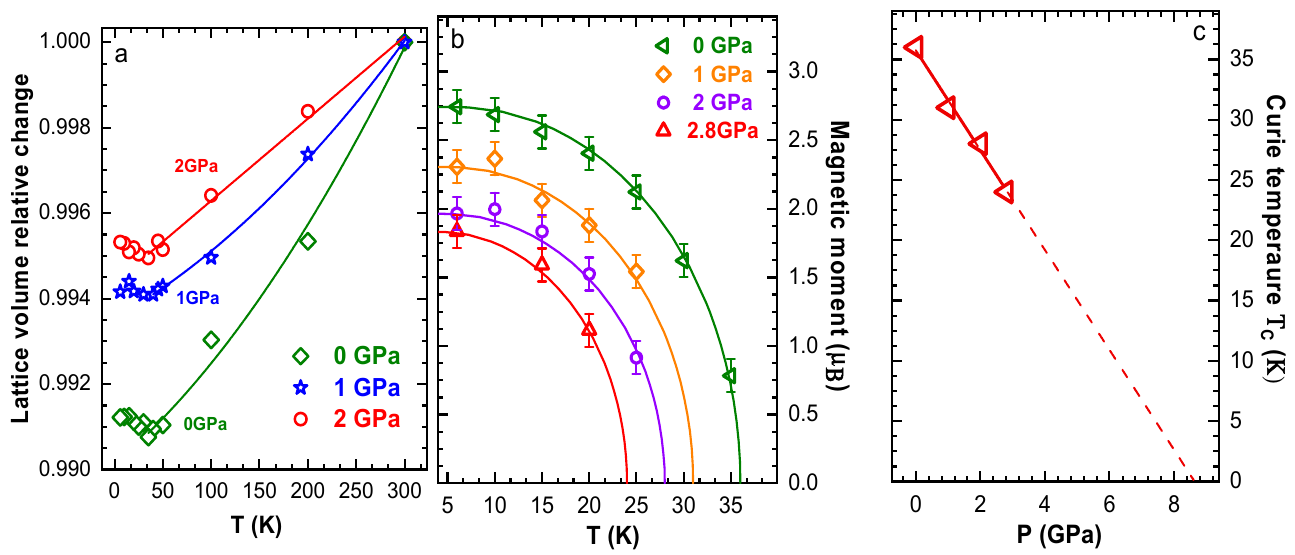
Figure 3. ( a ) The temperature dependences of the unit-cell volume obtained from neutron diffraction and normalized to the ambient temperature values; ( b ) The temperature dependences of the ordered Cr 3+ magnetic moments at selected pressures. The solid lines represent fitting by function described by Equation (2); ( c ) Curie temperature as a function of pressure and its linear extrapolation.